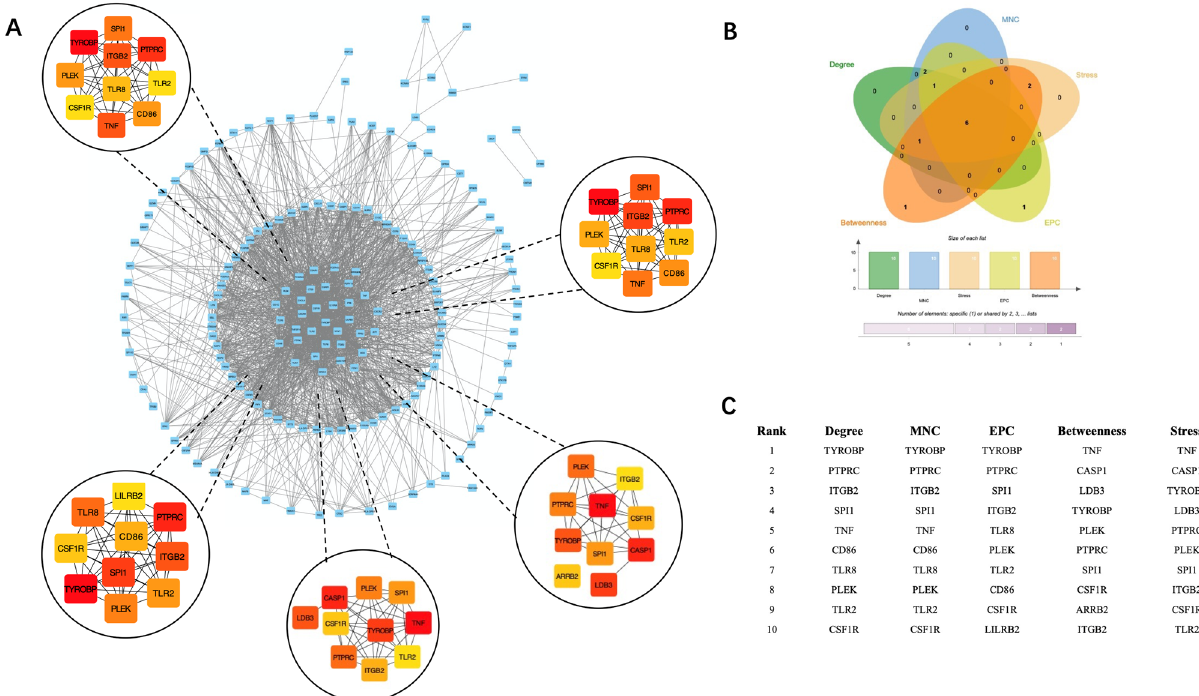
Figure 9. Identification of hub genes. ( A ) Visualization of the protein–protein interaction (PPI) network of the coincident part of two modules (MEbrown and MEturquoise) and visualization results of five algorithms of CytoHubba (STRING (v11.0) and Cytoscape software (v3.8.2)). ( B ) Venn diagram among five algorithms of CytoHubba. The intersection presented the hub genes (TYROBP, PTPRC, ITGB2, SPI1, PLEK, and